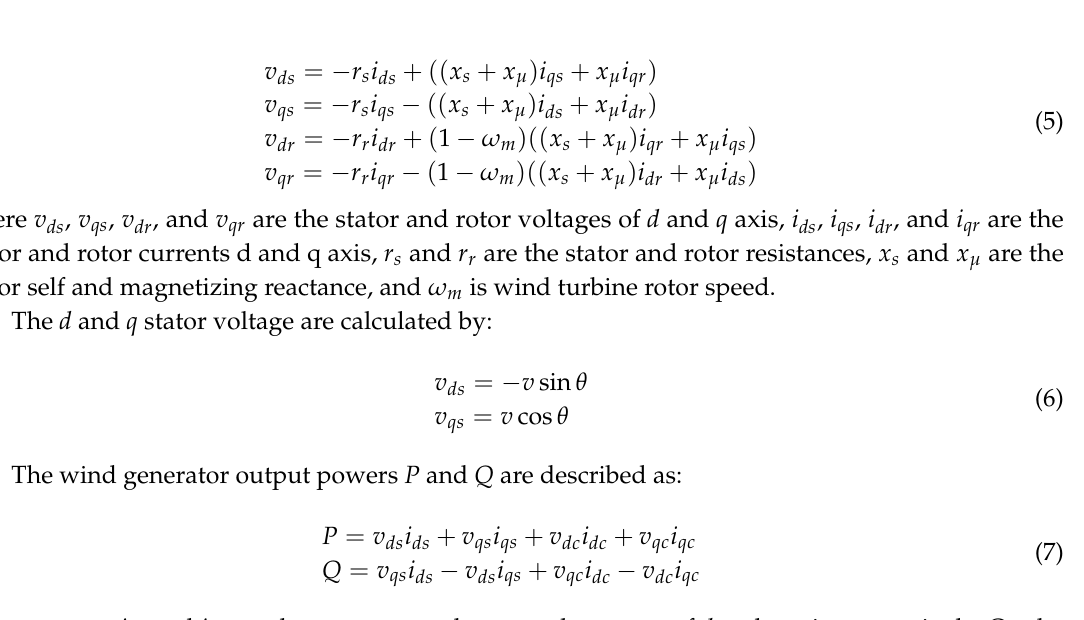
Figure 4. The structure of the doubly-fed induction generator (DFIG) and vector control strategy.